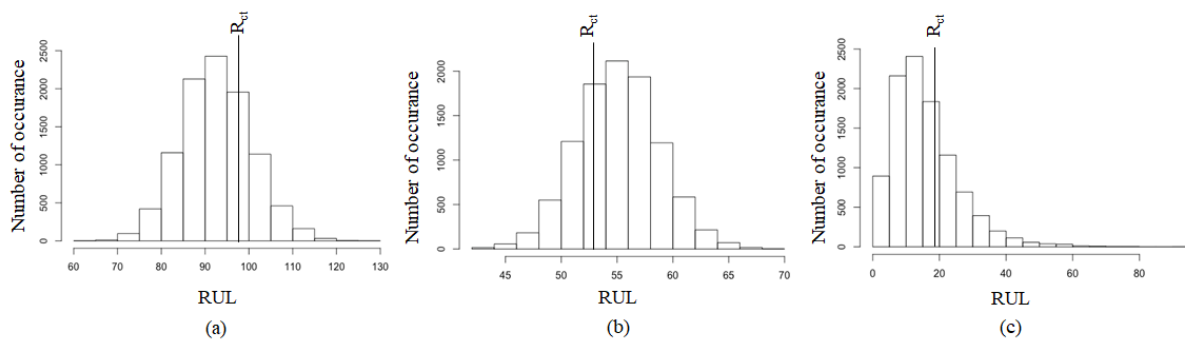
Figure 10. Position of the real crossing time R ct compared to the histograms of RUL for simulated data with NN algorithm: ( a ) Slow, ( b ) moderate, and ( c )